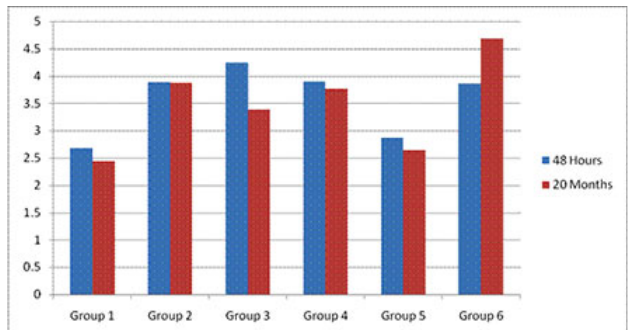
Fig. 1. Mean of Microleakage of each group after 48 h and 20 months.